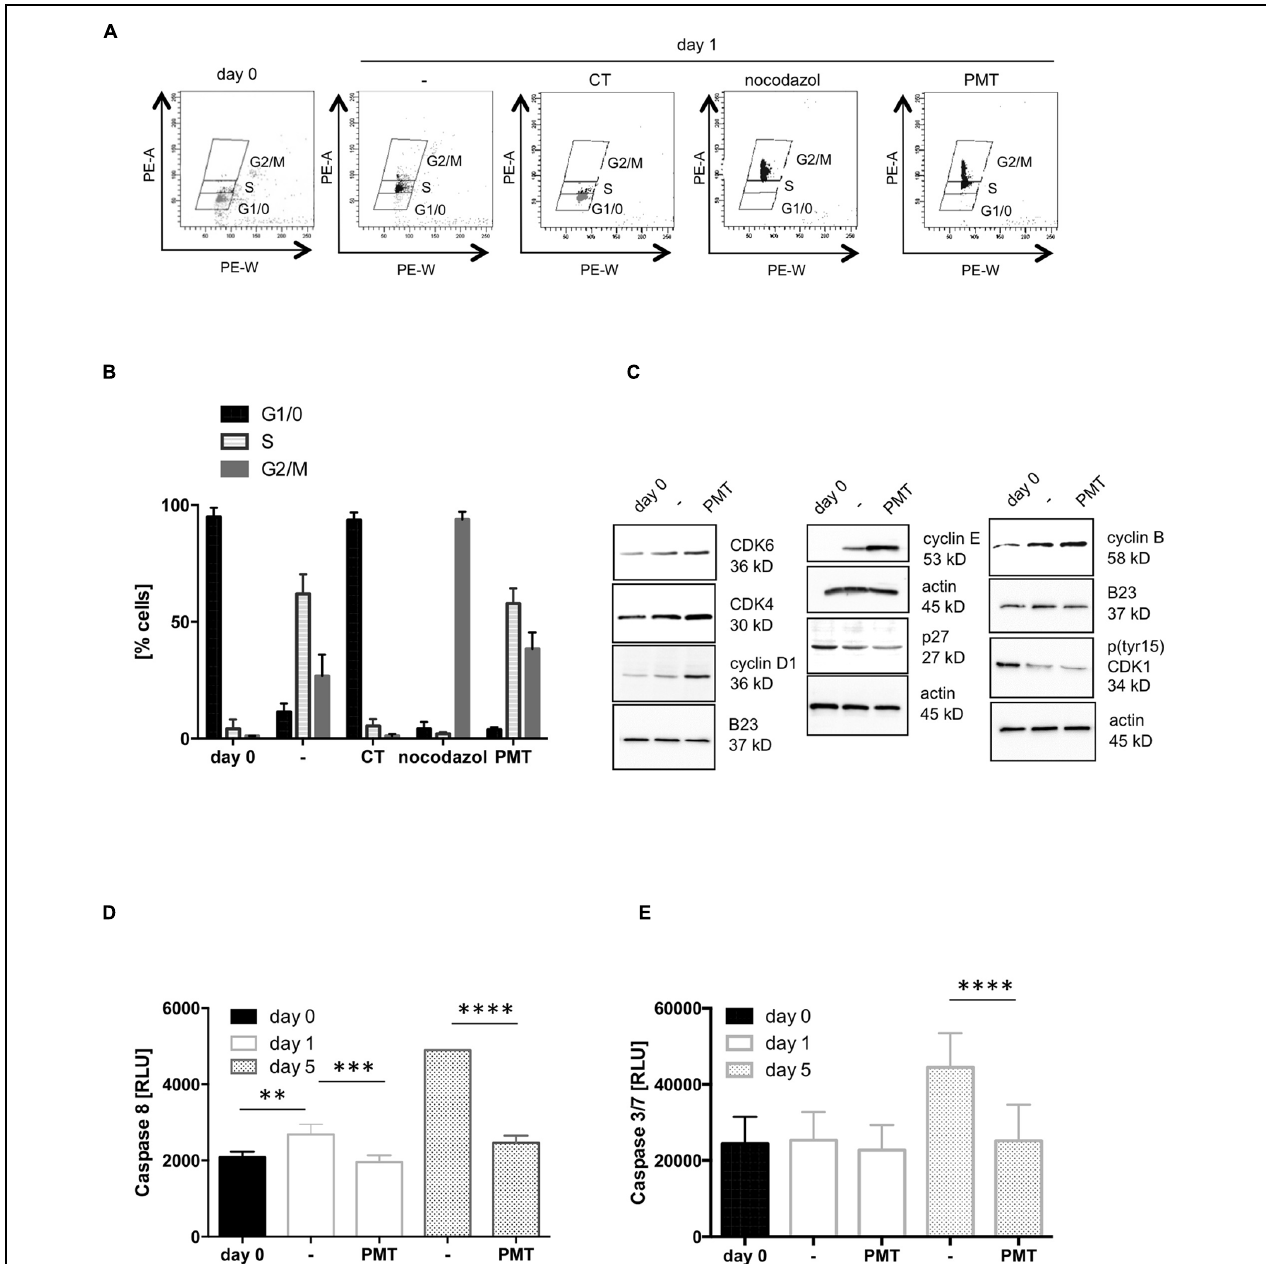
FIGURE 2 | PMT stimulates cell cycle progression. (A) CD4-positive T cells were cultured overnight without activation to synchronize cells in G0 phase. Then cells were CD3/CD28-activated and stimulated with PMT for 24 h. As controls, cells were treated with 100 ng/ml CT (G0/1 phase) or 100 ng/ml nocodazole (G2 phase). Nuclei were stained with propidium iodide (PI) and intensity of the PI signal was quantified by flow cytometry ( x -axis: PE-A, y -axis: PE-W). (B) Quantification of the percentage of cells in G1/0, S and G2/M phase (mean ± SD, n = 3). (C) Cell lysates were used for western blot analysis with specific antibodies against cyclin B, pCDC2 (CDK1), cyclin D1, cyclin E, CDK4, or p27. Equal loading was verified by detection of actin (whole cell lysates) or B23 (nuclear extracts). The results were corroborated with two more donors. (D,E) T cells were stimulated with PMT for 1, 3, or 5 days, lysed and the activation of caspase-8 (D) or caspases 3 and 7